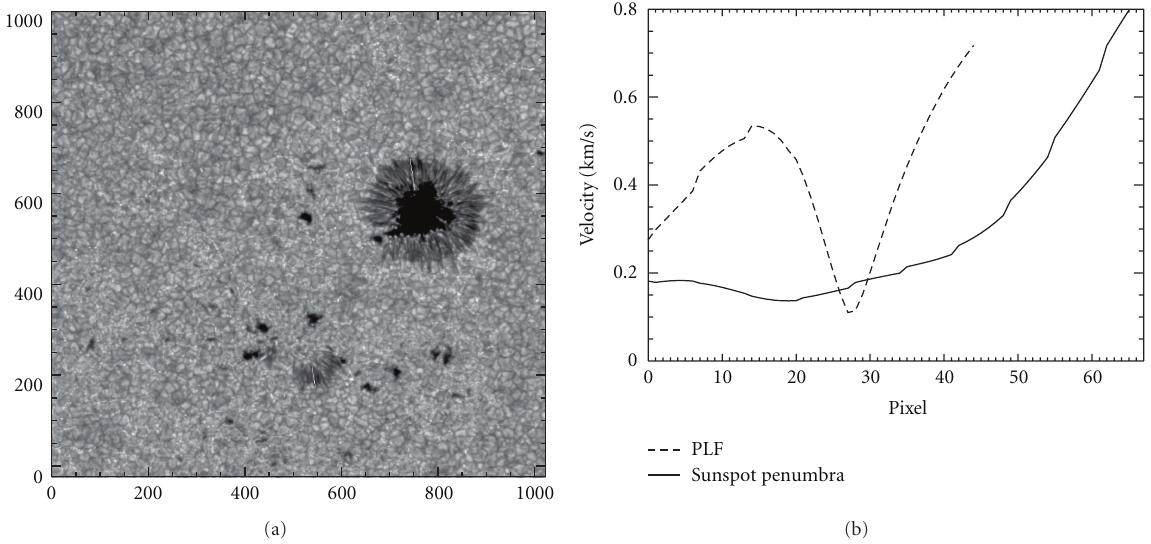
Figure 6: (a) The location of the velocities extracted for the penumbra associated with the sunspot, and the PLF is shown with white line. (b) The velocity for penumbral region and PLF region is